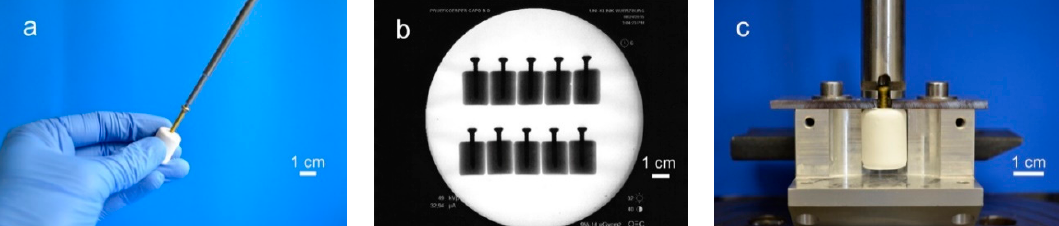
Figure 1. Screw pullout test setup. Workflow of specimen preparation for pullout tests: ( a ) In case of the drillable bone substitute, screws could be manually drilled into the cement. In all other cases screws were embedded in silicon rubber molds, in which cement was poured. ( b ) The cylindrical probes were then analyzed via X-rays to ensure equal screw placement, ( c ) prior to applying a tensile load with a custom-made test device for screw pullout.